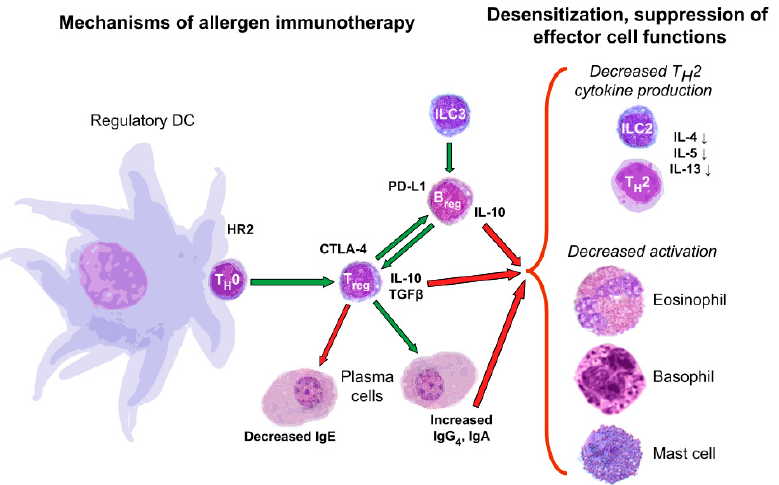
Figure 1. Schematic representation of the mechanism of tolerance generation by antigen ‐ specific immunotherapy. This image is reproduced with permission from reference [5]. Copyright© 2021, Elsevier.